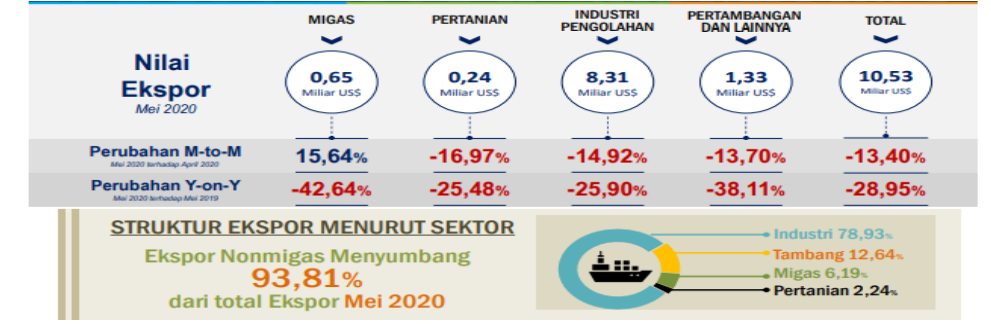
Figure 3: Indonesia Score